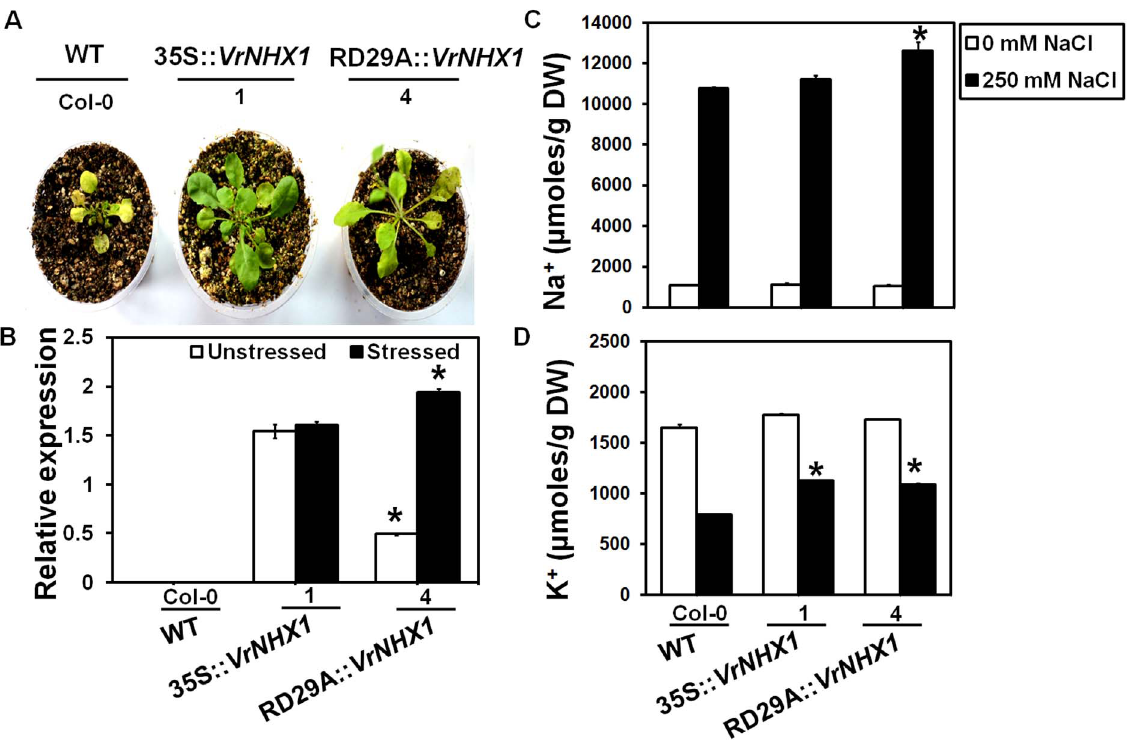
Figure 11. Salt tolerance assay in mature transgenic Arabidopsis lines under salt stress. (A) Effect of salt stress on wild type (WT, Col-0) and transgenic Arabidopsis lines expressing VrNHX1 constitutively (Line 1, 35S:: VrNHX1 ) and inducibly (Line 4, RD29A:: VrNHX1 ) subjected to 250 mM NaCl treatment for 2 weeks (B) Relative transgene expression level of VrNHX1 in transgenic Arabidopsis lines under unstressed and salt stressed conditions. No transgene expression was observed in WT. A 0.283 kb fragment of VrNHX1 ::35SployA and 0.150 kb fragment of AtUBQ1 was amplified in quantitative RT-PCR analysis (C) Na + and (D) K + content ( m moles/g DW) was estimated in leaves of unstressed (0 mM NaCl) and salt stressed (250 mM NaCl) WT and transgenic lines, as described in materials and methods. Values indicate means 6 SE (n=3). Statistically significant values at P # 0.05 are indicated as ‘‘*’’, using Bonferroni analysis.